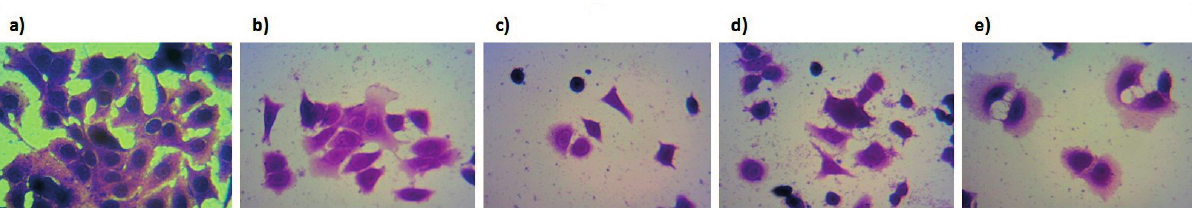
Figure 11. Light microscopy of MCF-7 cells stained with cystal-violet after 72 h of treatment with tested compounds 1 – 4 . Control cells ( a ) and cells treated with 500 µM 1 ( b ); 2 ( c ); 3 ( d ) and 4 ( e ). Magnification